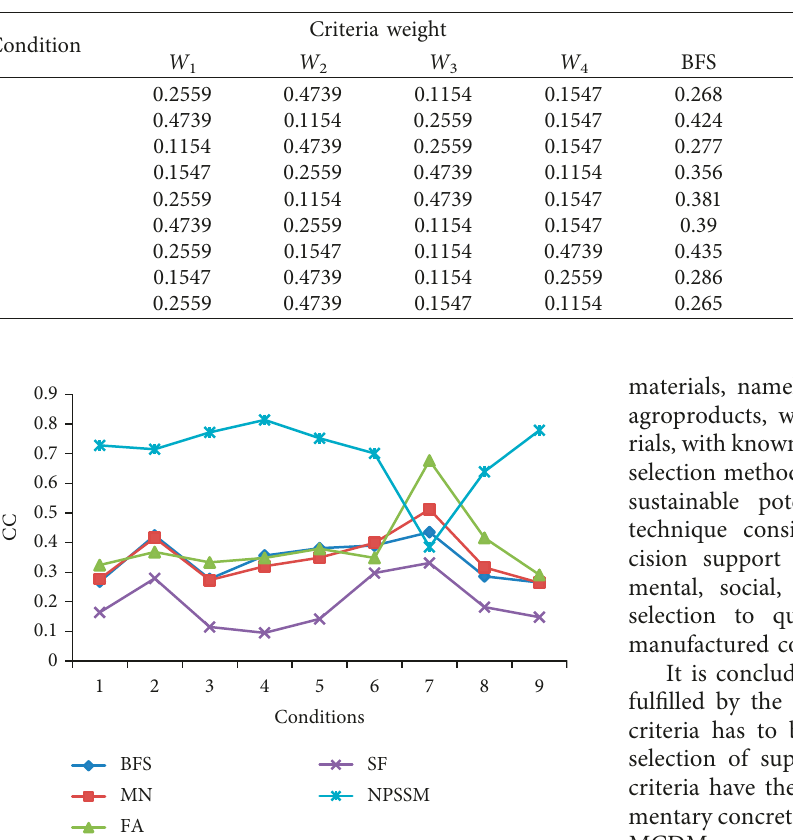
Figure 2: Sensitivity analysis with respect to objective